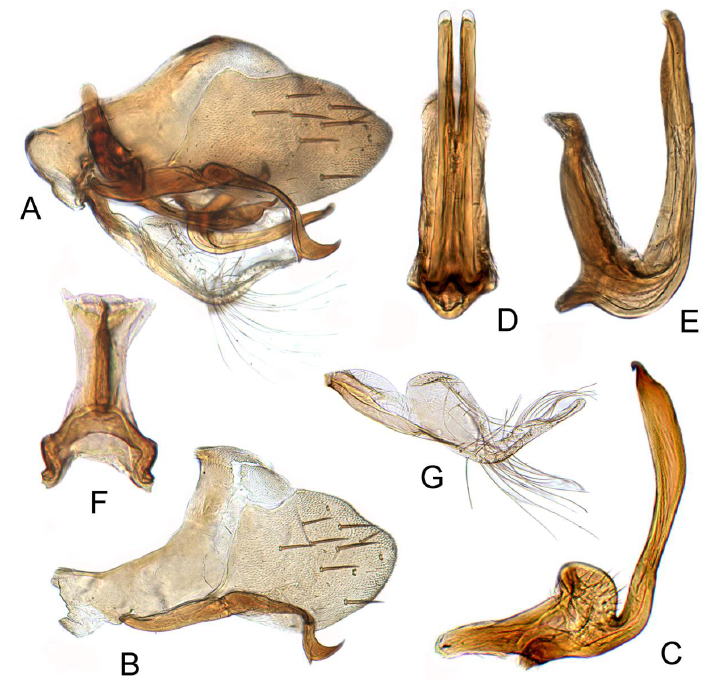
Figure 9. Batracomorphus fletcheri sp. nov.: ( A ) genital capsule in lateral view; ( B ) pygofer side and pygophore processes; ( C ) paranere; ( D ) aedeagus, ventral view; ( E ) aedeagus, lateral view; ( F ) connective; ( G ) sub-genital plate. Material examined. 1 ♂ , Shaanxi, Zhuque Forestry Park, 22~25.vii.2007, Dai Wu (Fig- ure 1). Other material: 1 ♂ , Hunan, Hupingshan, 20.vii.2006, 1040 m, Lv Lin; 2 ♂ , Zhejiang, Tianmushan, 27~26.viii.2000, Dai Wu and Wei Cong (NWAFU). Distribution. China (Shaanxi, Zhejiang, Hunan)